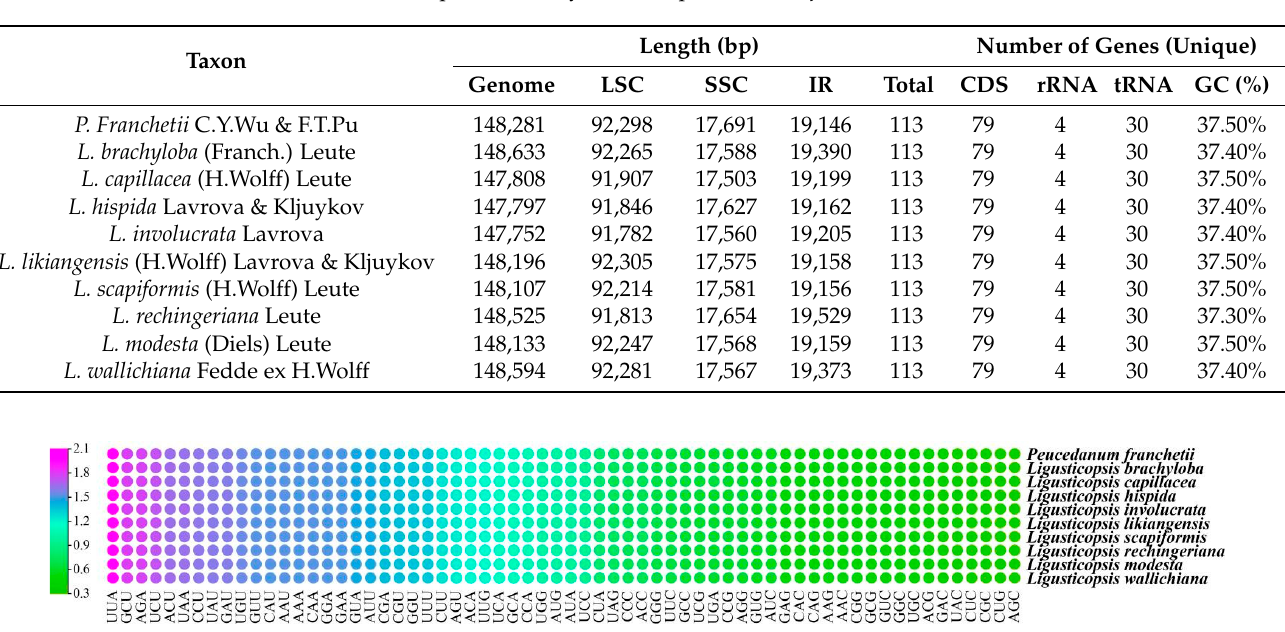
Figure 3. The RSCU values of all concatenated protein-coding genes for ten plastomes. Color key: the purple values represent higher RSCU values while the green values indicate lower RSCU values. This work also predicted the RNA editing sites of the ten plastomes. We found 22–23 protein-coding genes and identified 57–59 potential RNA editing sites in the 10 plas- the most editing sites (22), while other genes ( atpA , ccsA , petG , psaI , psbE , psbF , rpl20 , rpoA ,